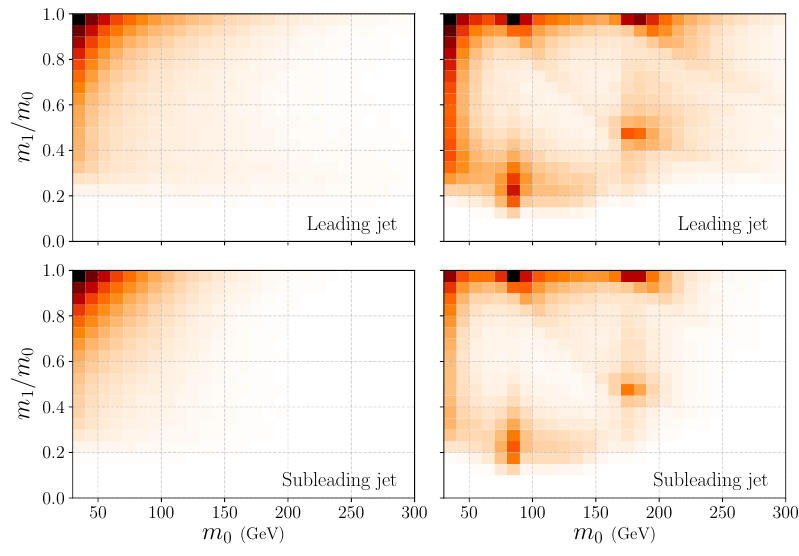
Figure 5 . Distributions of QCD (left) and t (cid:22) t (right) di-jet events in the ( m text for